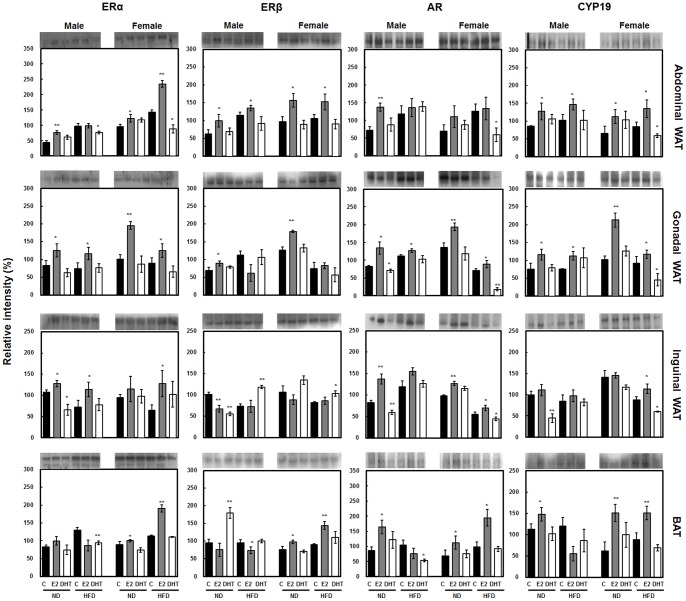
Sex-dimorphic differential expression of estrogen receptors (ERα and ERβ), androgen receptor (AR), and aromatase (CYP19) in different adipose tissue depots.Band densities were normalized using β-actin in each tissue to calculate relative intensity (%). Statistical significance between control and hormone treated groups were calculated by Student’s t-test, where, *p<0.05 and **p<0.01. The significance of the effects of sex, diet and hormonal treatments was tested using multivariate ANOVA (M-ANOVA), where p<0.05.